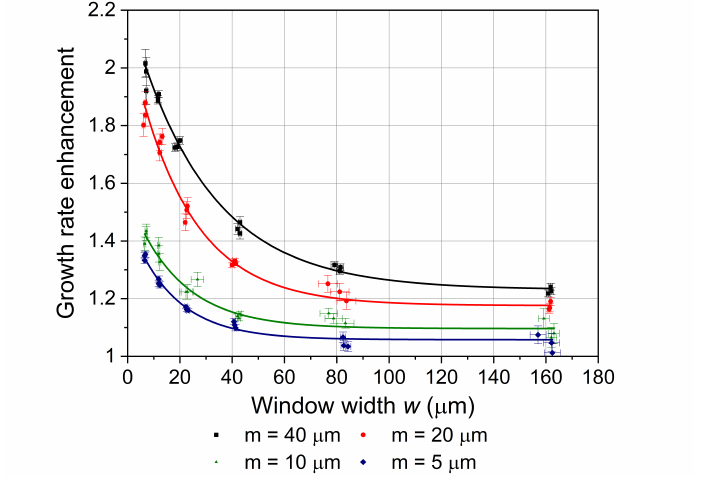
Figure 7. GRE as a function of the window width adjacent to the mask GRE edge = f ( w ) (layer thickness 500 nm).